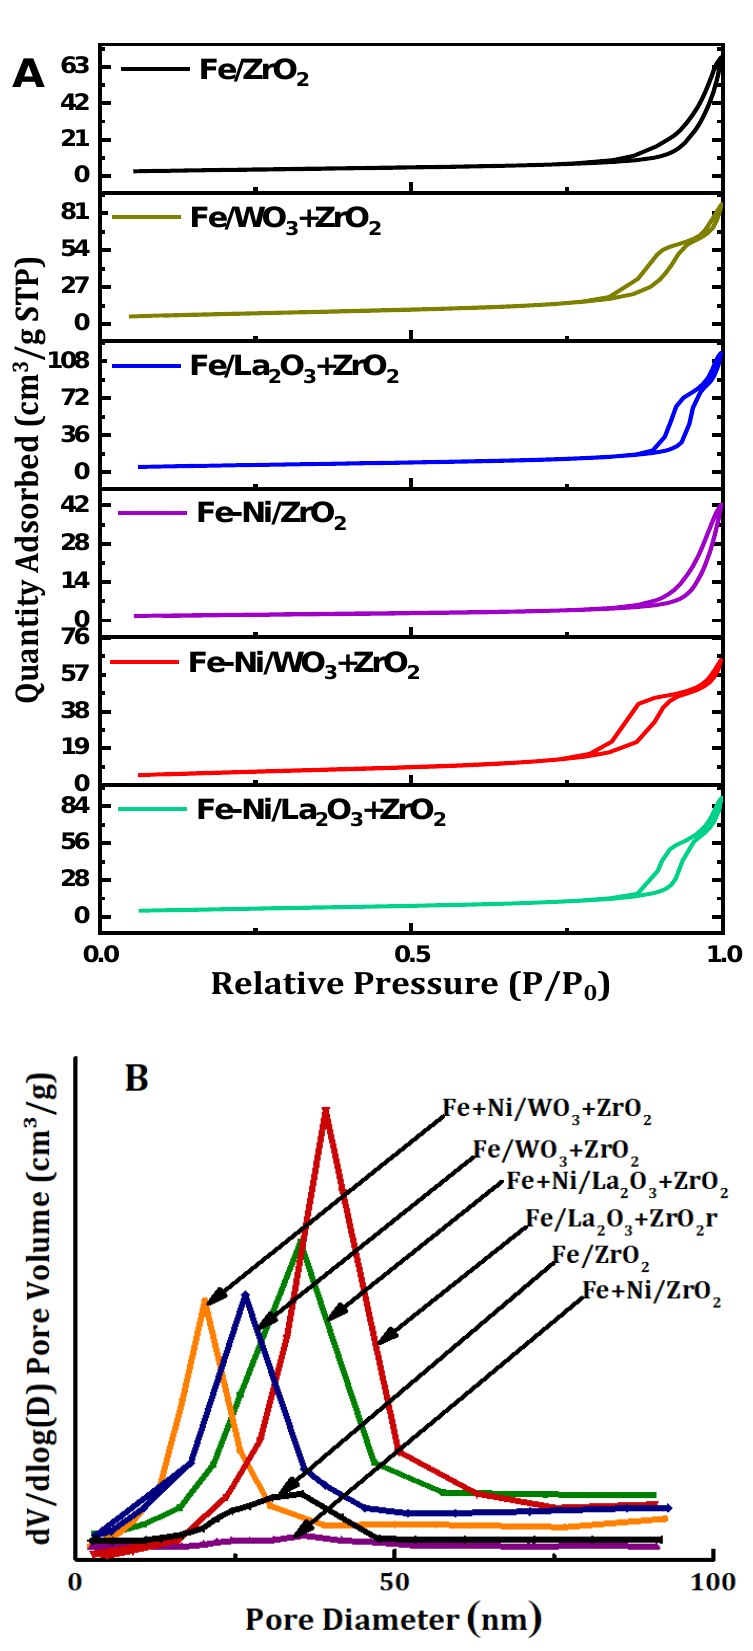
Figure 2. ( A ) The N 2 physisorption isotherms and ( B ) pore size distribution of Fe and Fe-Ni-supported x-ZrO 2 (x = 0, La 2 O 3 , WO 3